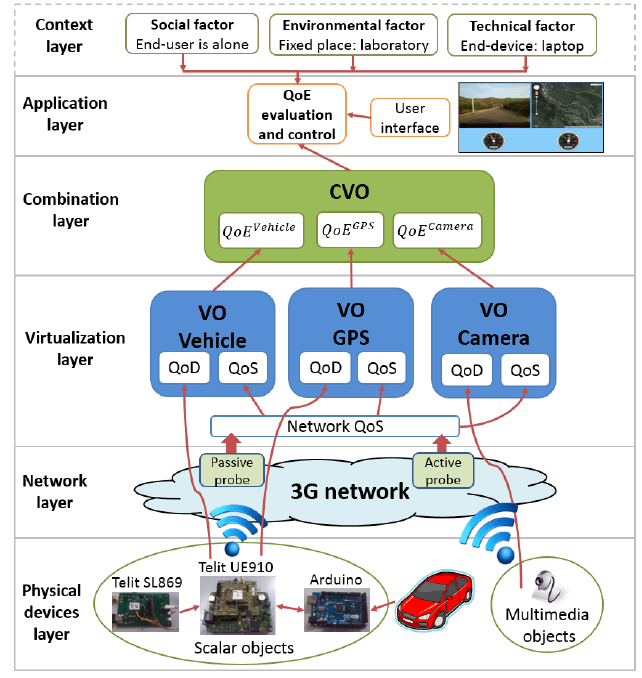
Figure 5. Framework of the MIoT vehicle application for remote tutoring for driving school